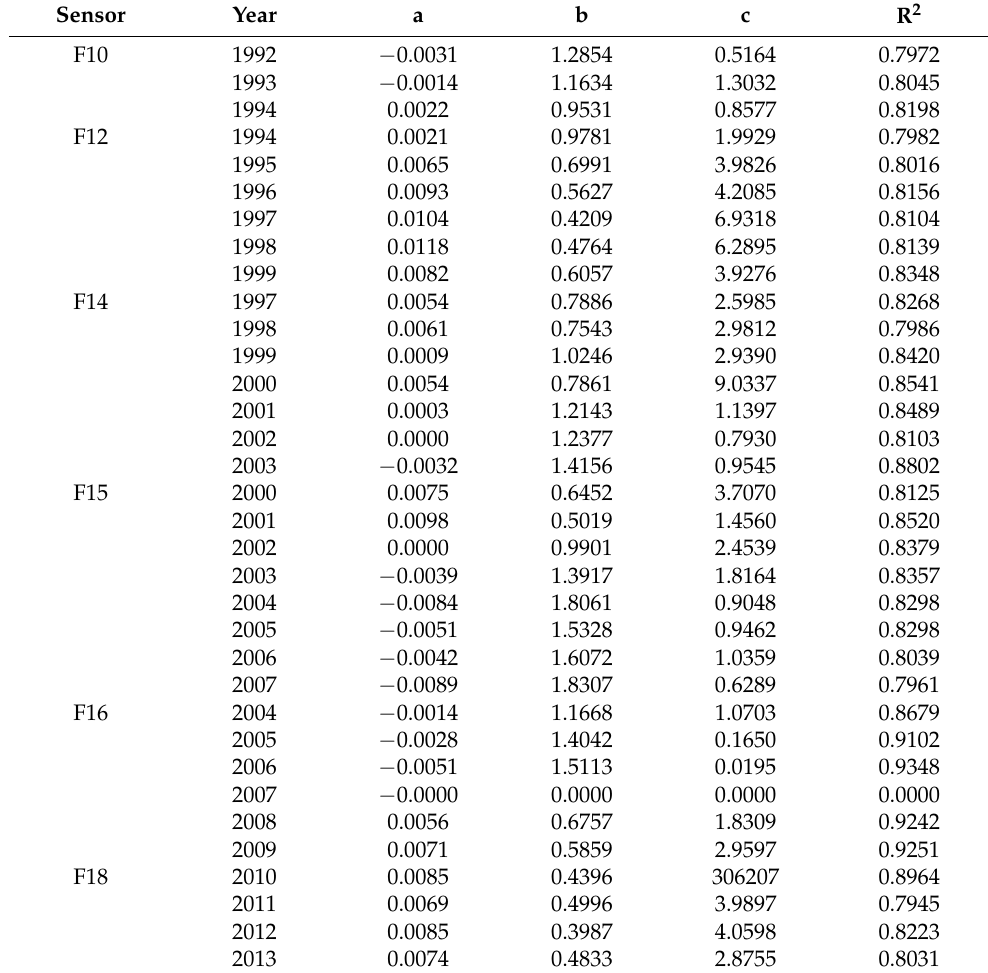
Table 1. Values of coefficients a, b, and c of data